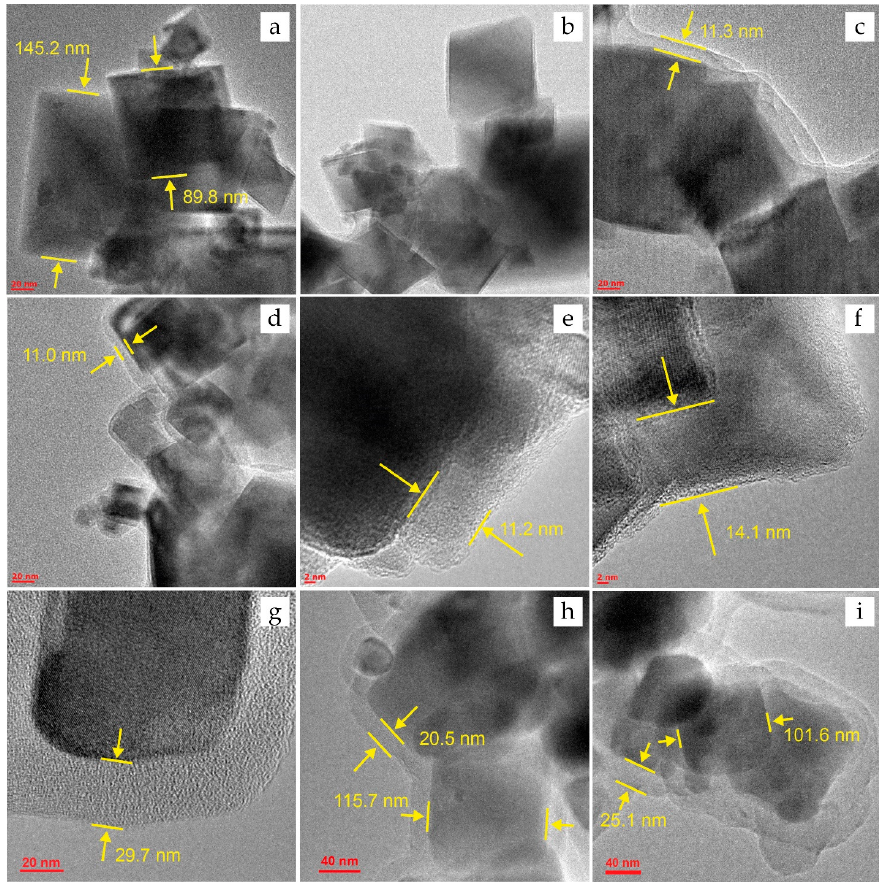
Figure 1. HRTEM images for the IONs before DOX sorption: ( a )—Fe 3 O 4 , ( c )—Fe 3 O 4 @PSS, ( e )—